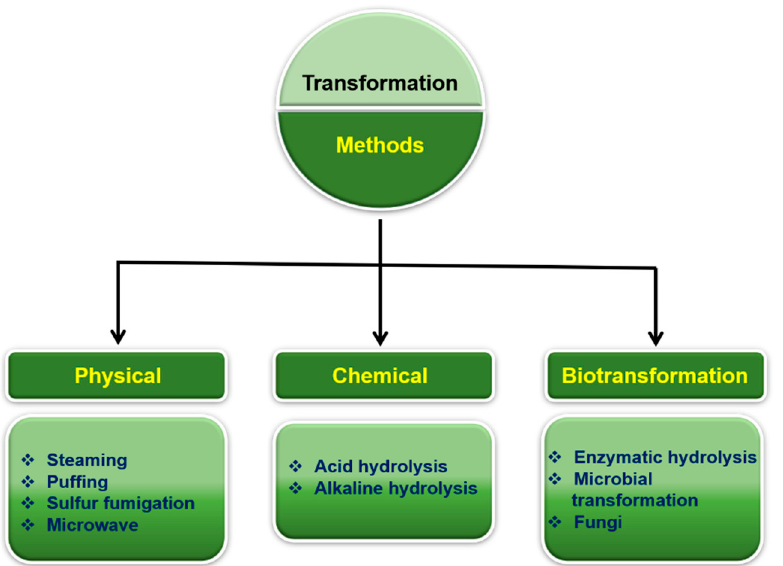
Figure 3. Transformation of ginsenosides using physical, chemical and biotransformation methods. These methods transform a ginsenoside into another ginsenoside by altering the chemical structure of the ginsenoside.